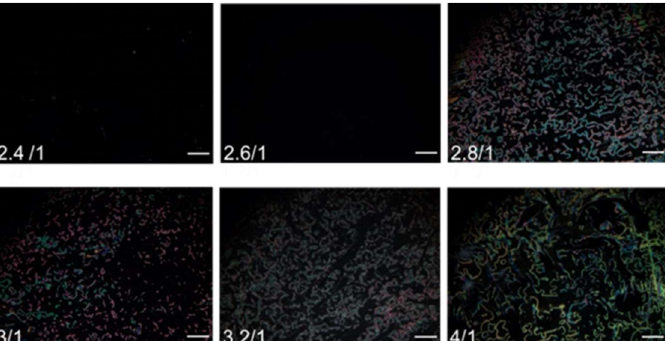
Figure 2. Optical texture of E7 on glass substrates coated with the PVA/DMOAP composite. The nematic LC E7 was sandwiched between two glass substrates coated with PVA/DMOAP mixtures of various mass ratios (2.4:1, 2.6:1, 2.8:1, 3:1, 3.2:1, and 4:1). Scale bar: 500 µ m.